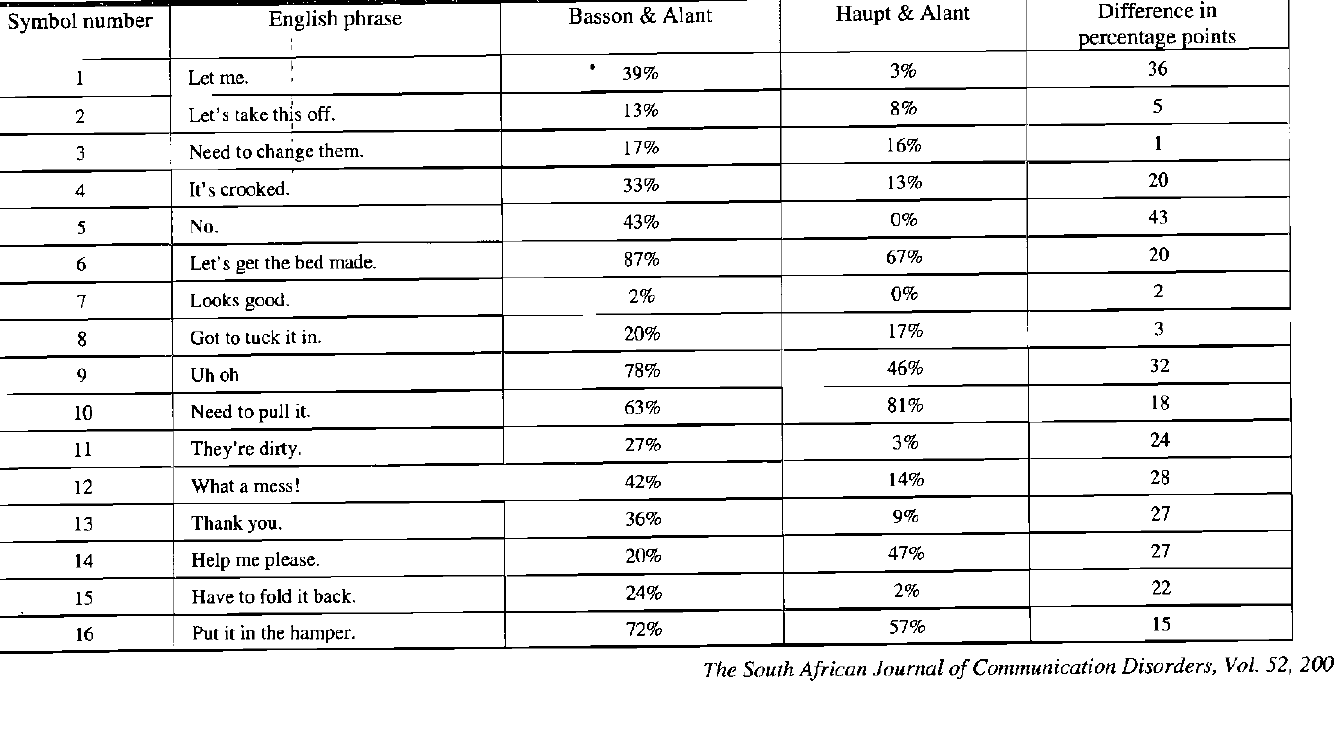
Tabled A comparison between Basson and Alant and Haupt and Alant's (2002)